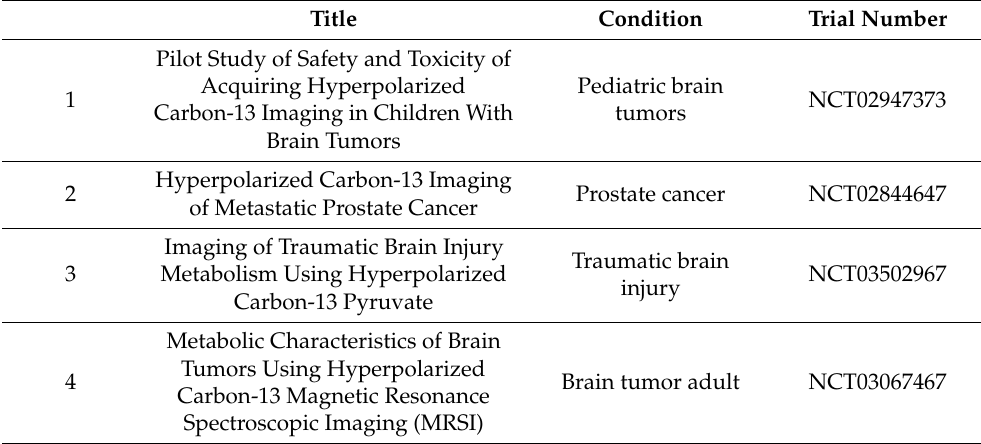
Table A2. Studies reported to clinicaltrials.gov as “active, not recruiting” or “recruiting” on hyperpo- larized carbon-13